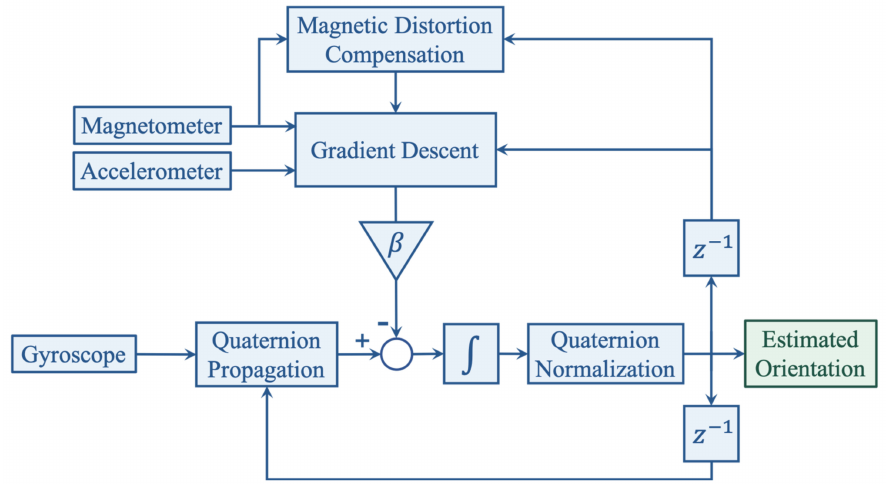
Figure 4. Block diagram of the orientation estimation through sensor fusion [34].